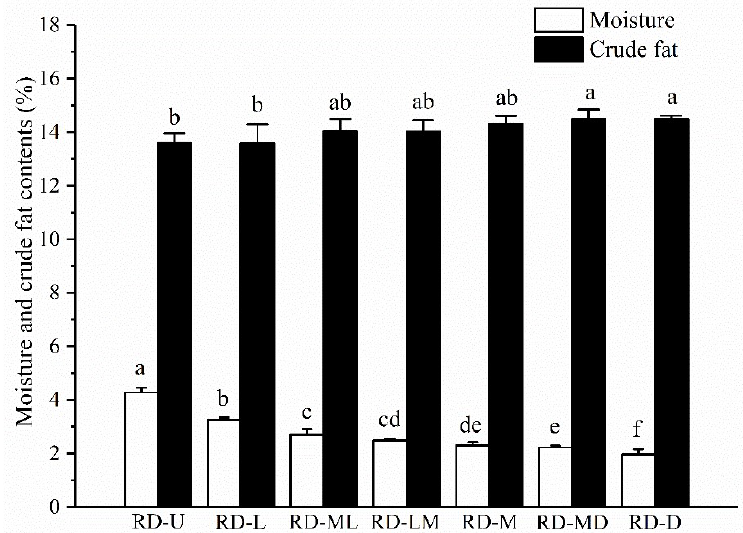
Figure 2. The moisture and crude fat contents of the seven roasting degrees of coffee beans. Different lowercase letters show significant differences among the groups at P < 0.05. The vertical bars represent means ± SD, n = 3. RD-U: unroasted; RD-L: light; RD-ML: moderately light; RD-LM: light medium; RD-M: medium; RD-MD: moderately dark; and RD-D: dark.